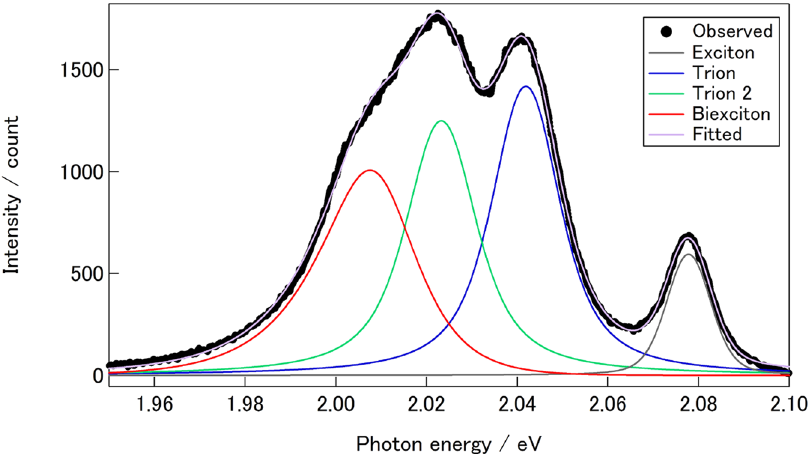
Figure 5. A PL spectrum of WS 2 / h BN measured with low excitation power, 2.8 μ W/240 W/cm 2 . Solid lines correspond to contributions from excitons, trions, P 1 and P 2 peaks, which were modeled by the pseudo-voigt function. The excitation energy of 2.54 eV was used to measure the